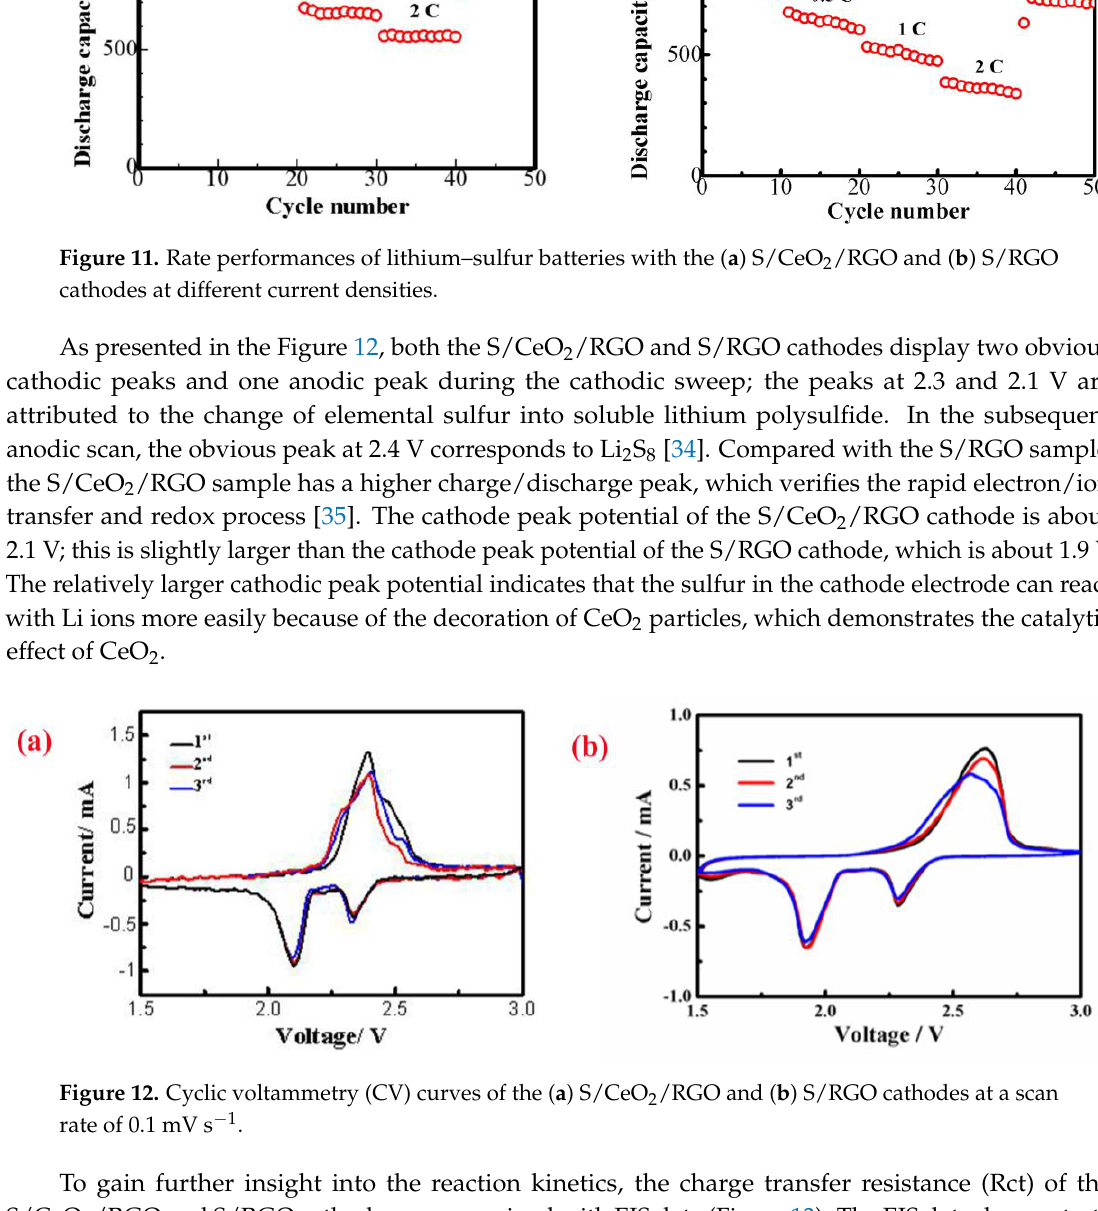
Figure 13. Electrochemical impedance spectroscopy (EIS) Nyquist plots of the ( a ) S/CeO 2 /RGO and ( b ) S/RGO electrodes. As shown in Table 1, the performance of 3D S/CeO 2 /RGO cathode is compared with other reported results. The results show that the prepared 3D S/CeO 2 /RGO cathode has good cycling performance. The discharge specific capacity is stable at 0.1 C, and the decay rate remains at 0.25% for 200 cycles. Table 1. Comparison of the electrochemical performances from previous reports and from our work. Cathodes